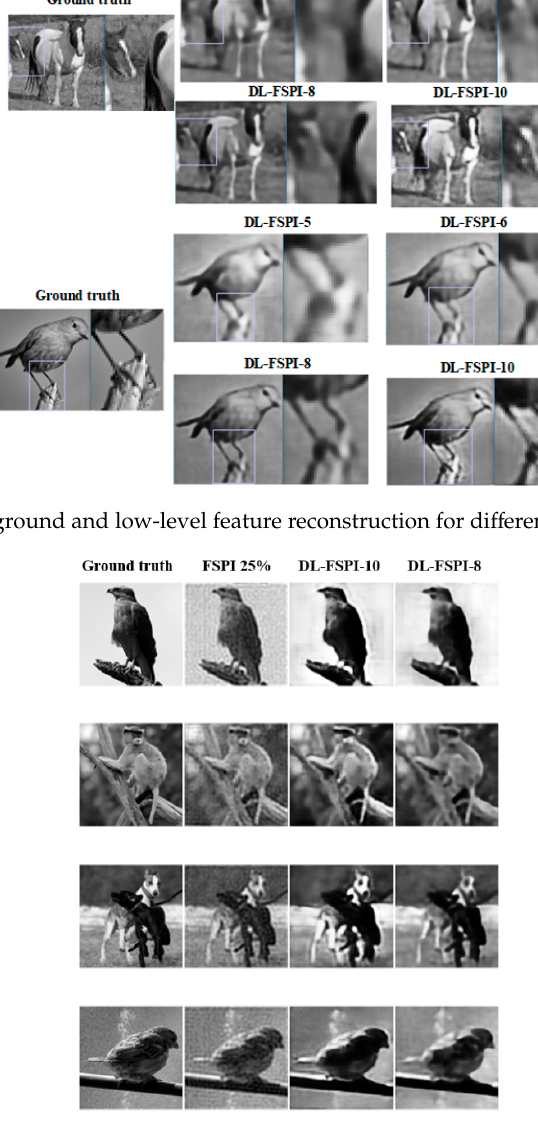
Figure 7. Image reconstruction quality comparison between FSPI and DL-FSPI.